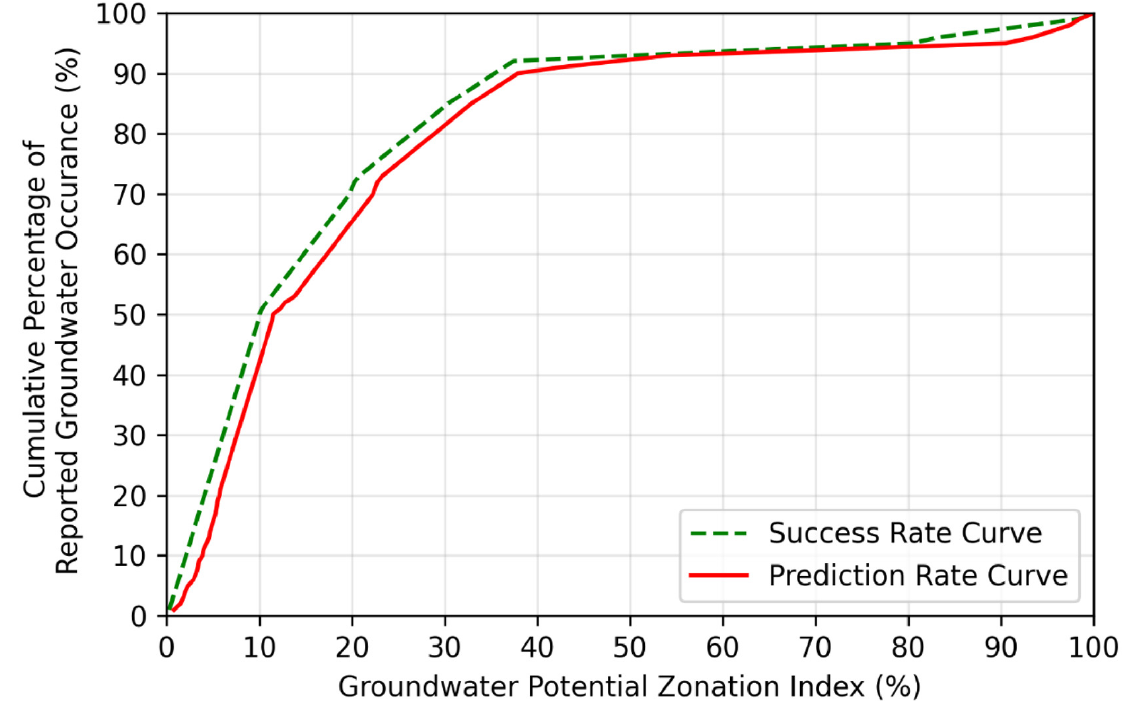
Figure 16. Groundwater potential zone map of study area, Bilaspur.